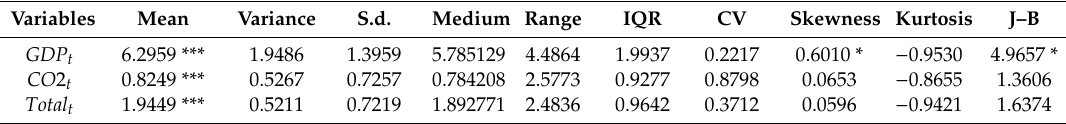
Table 1. Descriptive statistics for the variables.